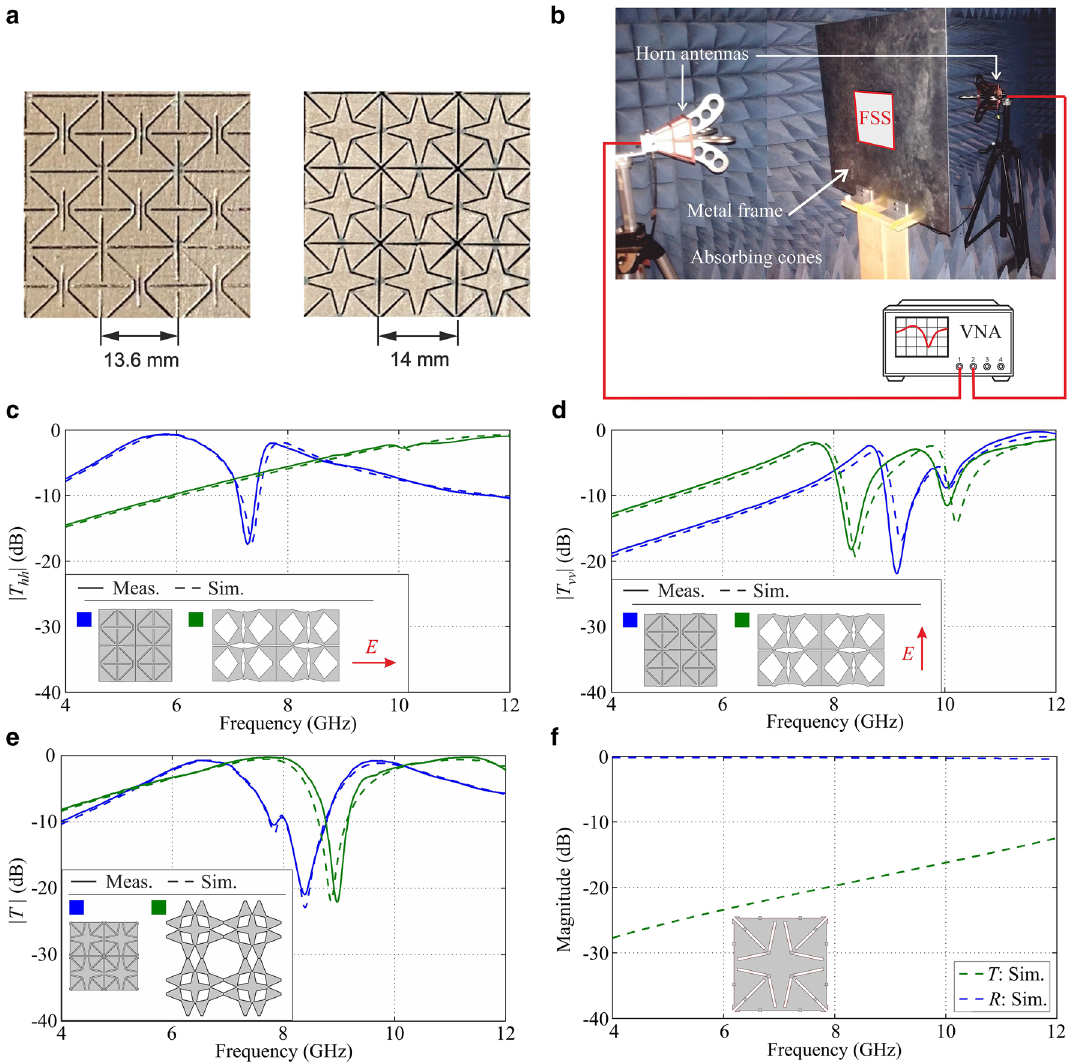
Figure 4. ( a ) FSS specimens. ( b ) Experiment setup. Measured and simulated transmittances of the triangle kirigami FSS in its closed and fully open configurations to a ( c ) horizontally and ( d ) vertically polarized incident wave. ( e ) Measured and simulated transmittance of the star kirigami FSS in its closed and fully open configurations. ( f ) Simulation of the switchable on–off FSS obtained by modifying the star pattern with the introduction of little metallic notches or tiny springs, as shown in the unit cell inset, which act as short circuits of the slots corresponding to the cuts defining the kirigami pattern in the closed configuration, while their presence has practically no effect when the FSS is stretched